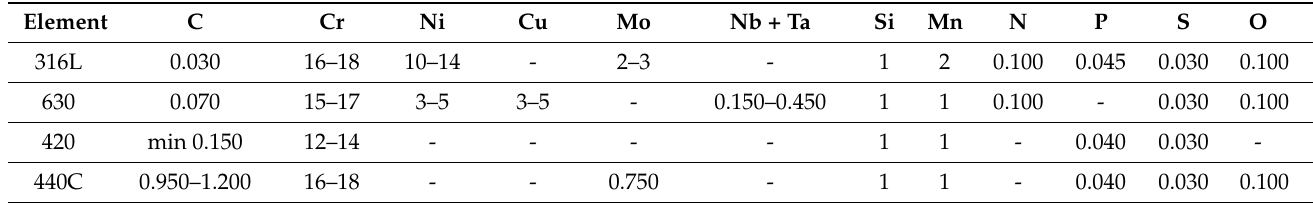
Table 1. Chemical compositions of the different stainless steels